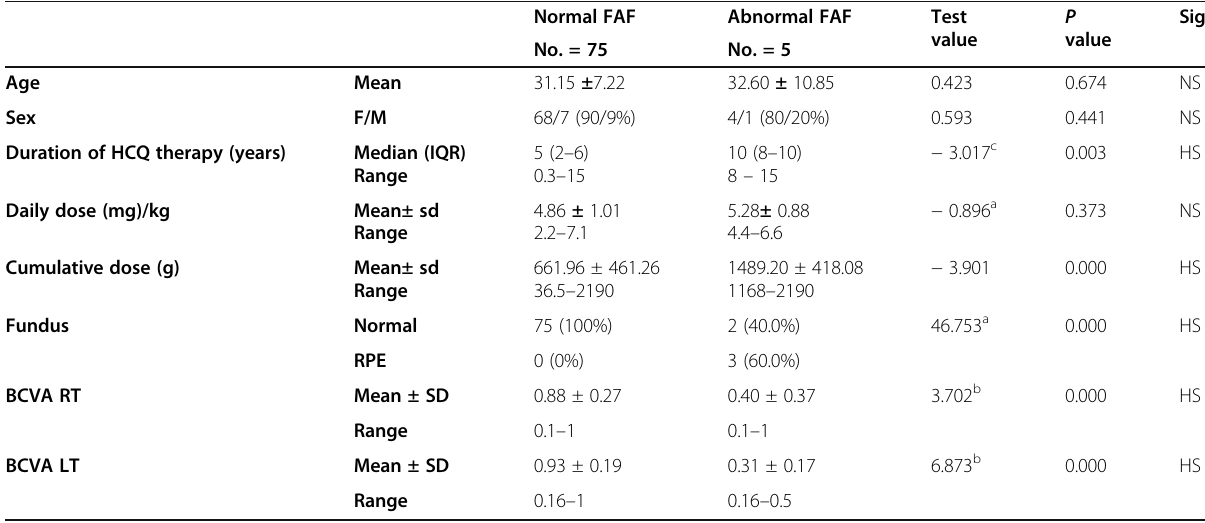
Table 2 Comparison between normal FAF group and abnormal FAF group